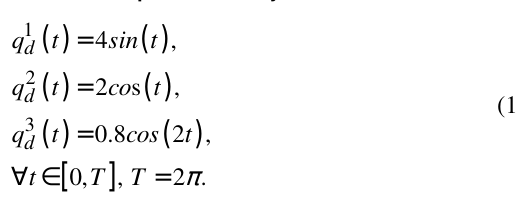
Figure 3. The adopted robotic system with 3 DOFs